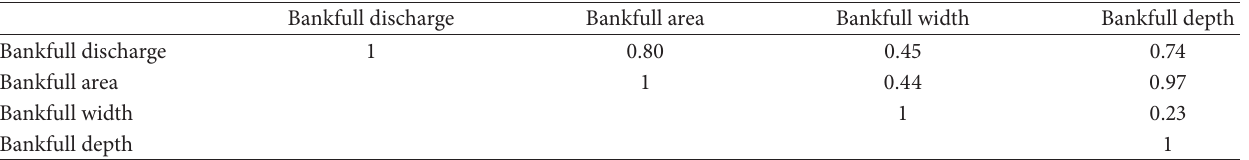
Table 1: Correlation matrix of the bankfull characteristics at Lijin